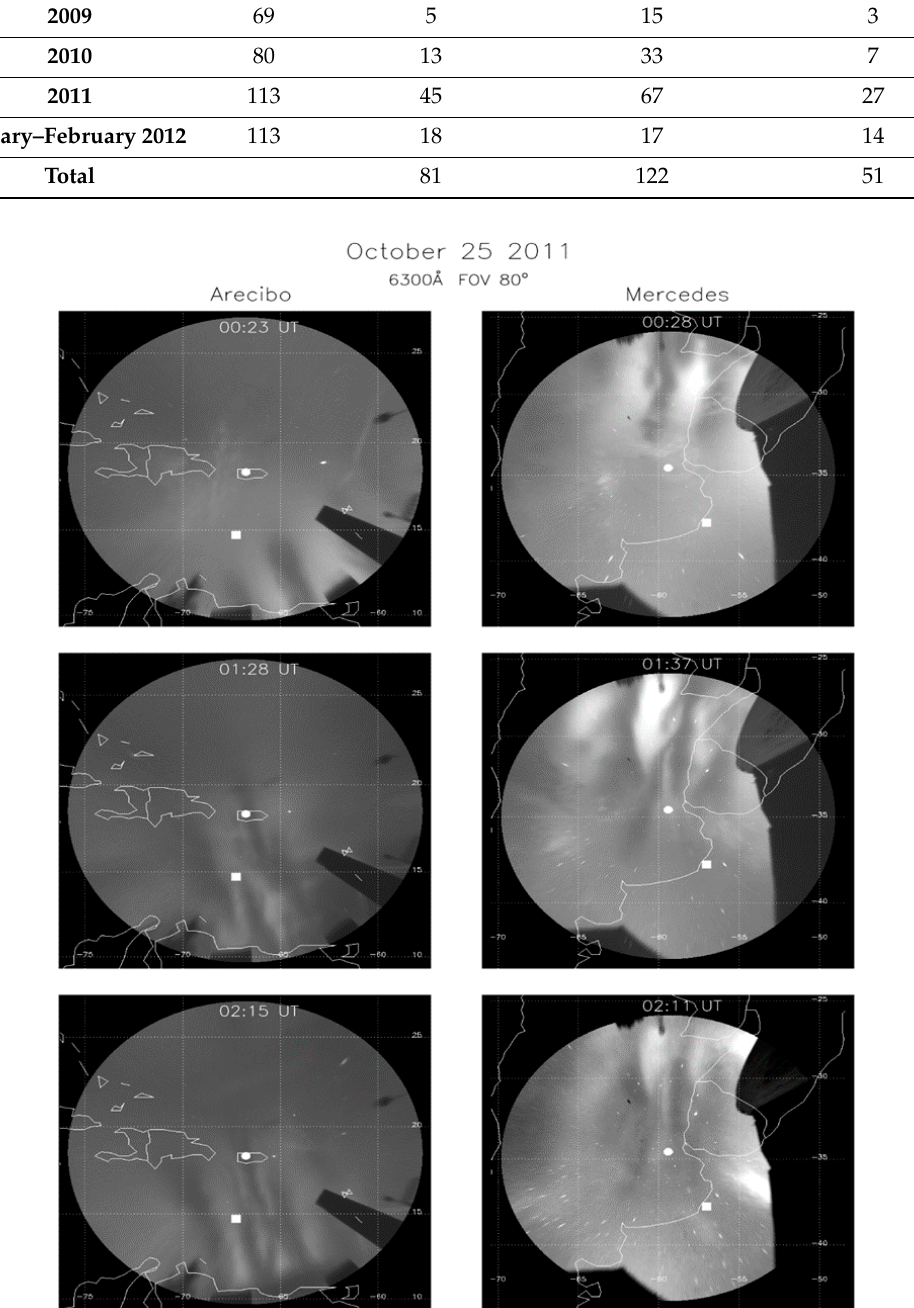
Figure 3. Simultaneous conjugate observations during 25 October 2011 from Arecibo ( left ) and Mercedes ( right ). Images at three different times show a one-to-one correlation between the structures observed at both sites. Images at both sites are unwarped using an altitude of 250 km. Depletions at Mercedes are wider and some of them do not reach latitudes as high as the ones over Arecibo. For example, the middle and bottom panels show a depletion that reaches a ~20° N passing through zenith in the Arecibo imager; but, it is not as clear in the Mercedes imager, hardly reaching the conjugate point, indicated as a white square.